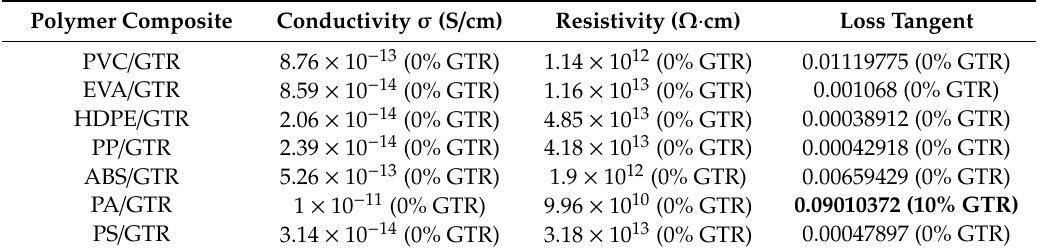
Table 4. Analysis of the suitable electrical property values of each property, and the composite regarded (size particle of GTR < 200 µ m).